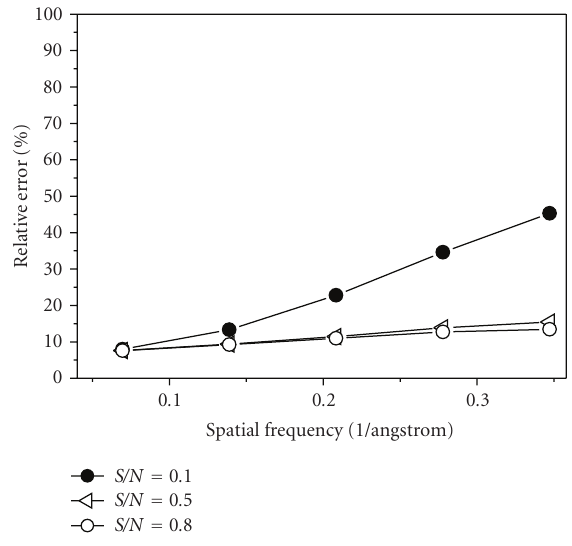
Figure 8: The relative error between the erythrocyte L Ferritin model and the results reconstructed by the OSAF